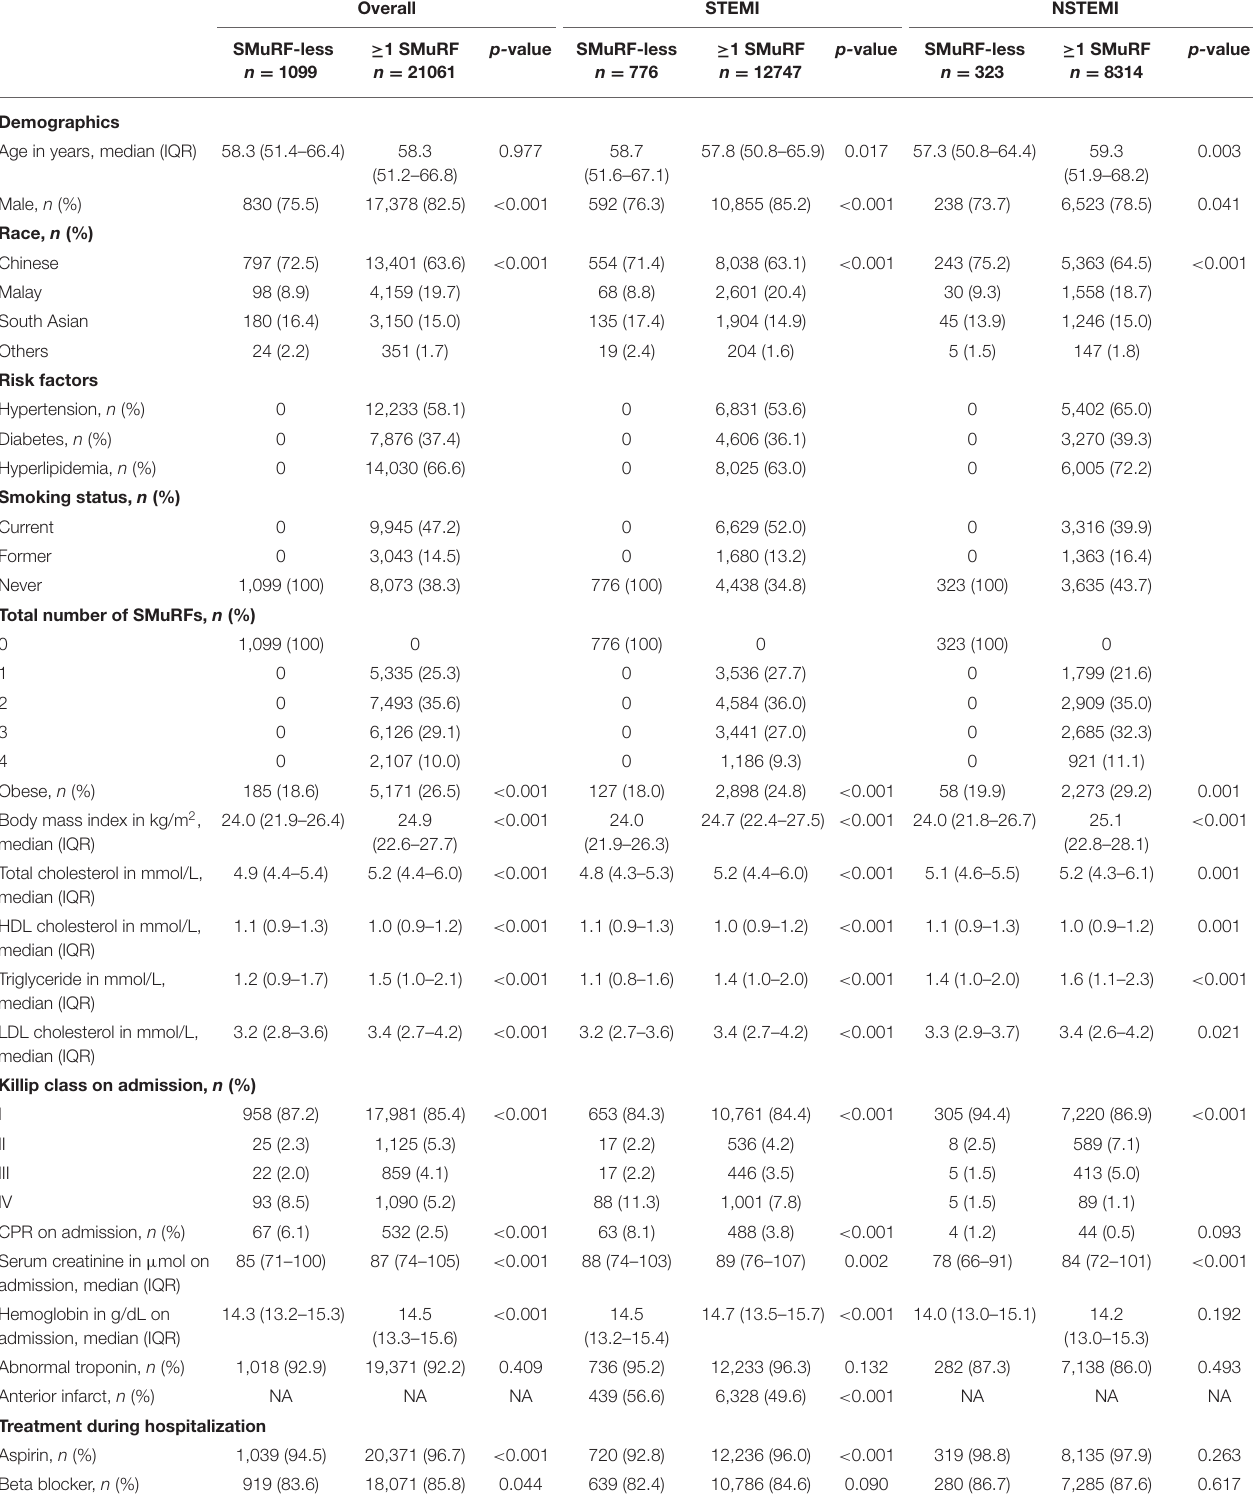
TABLE 2 | Baseline characteristics of STEMI and NSTEMI patients with respect to SMuRF (excluding obesity) ( n = 22,160).